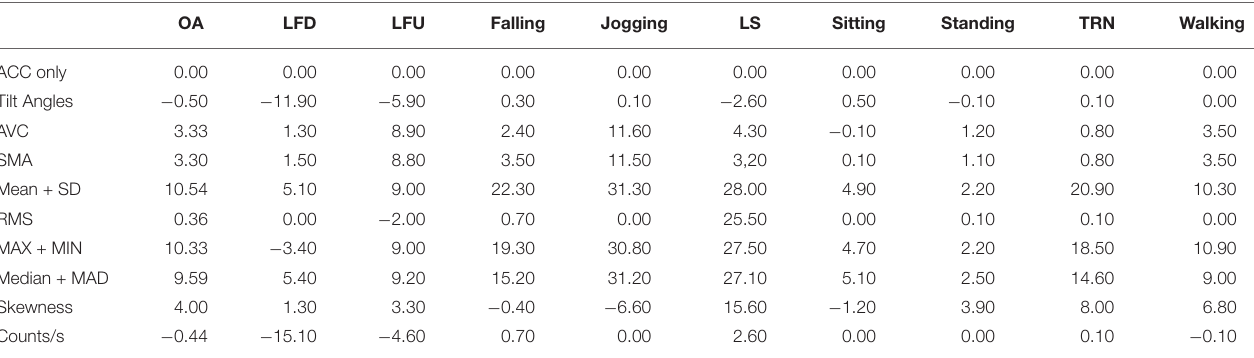
TABLE 3 | Accuracy improvement per feature and activity. OA LFD LFU Falling Jogging LS Sitting Standing TRN Walking